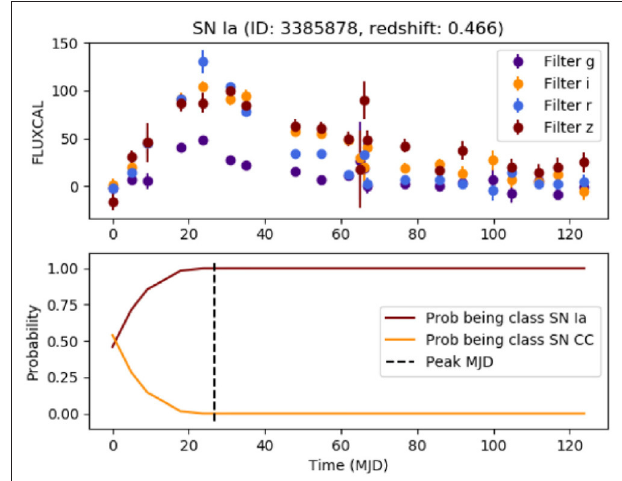
FIGURE 3 | Simulated type Ia supernova light-curve and classification. Top: calibrated flux evolution in different DES band-passes as a function of normalized time (the first photometric measurement is set to time equals zero). Bottom: Baseline RNN classification probability evolution with respect of time, no host-galaxy redshift information was provided. At each photometric measurement, classification probability is obtained. The maximum light of the simulated supernova is shown in a gray dashed line and the simulated redshift of the supernovae is shown on the top z = 0.466. We highlight that redshift is not used for this classification but can improve results. Our baseline RNN classifies this light-curve as type Ia SN with great accuracy before maximum light, it only requires a handful of photometric epochs. (Möller and de Boissiére,